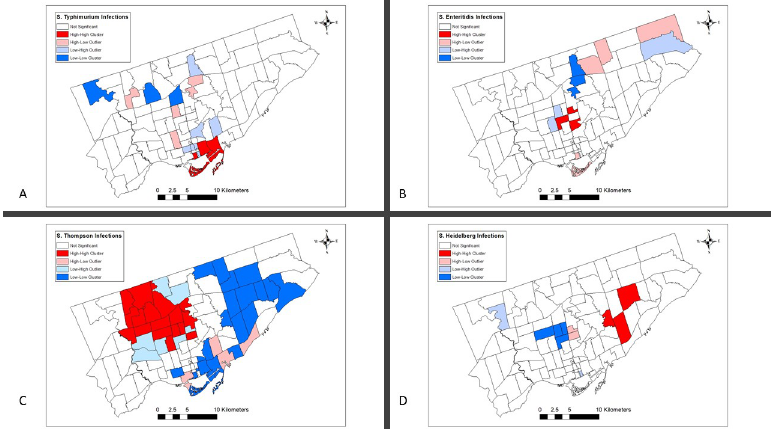
Fig 4. Local spatial clusters of nontyphoidal Salmonella enterica infections with serotypes (A) Enteritidis, (B) Typhimurium, (C) Thompson, and (D) Heidelberg in Toronto identified by the Moran’s I statistic. 1 Euclidean distance band of 3.3 km was used for serotype s Enteritids, Typhimurium and Heidelberg, and 6.3 km for serotype